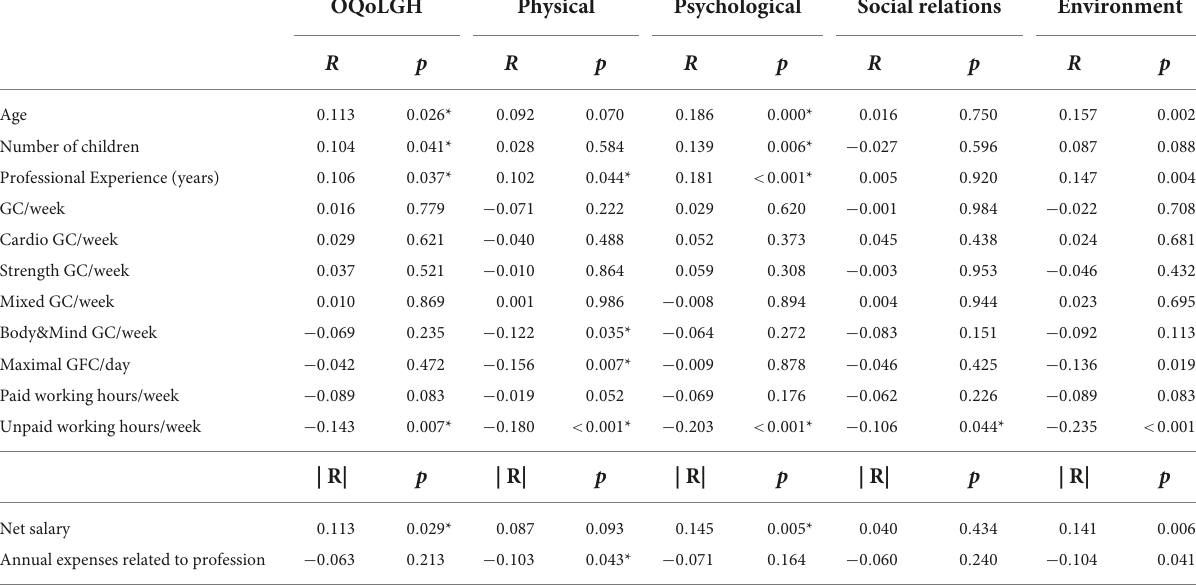
TABLE 4 Correlation/association statistics of QoL with the